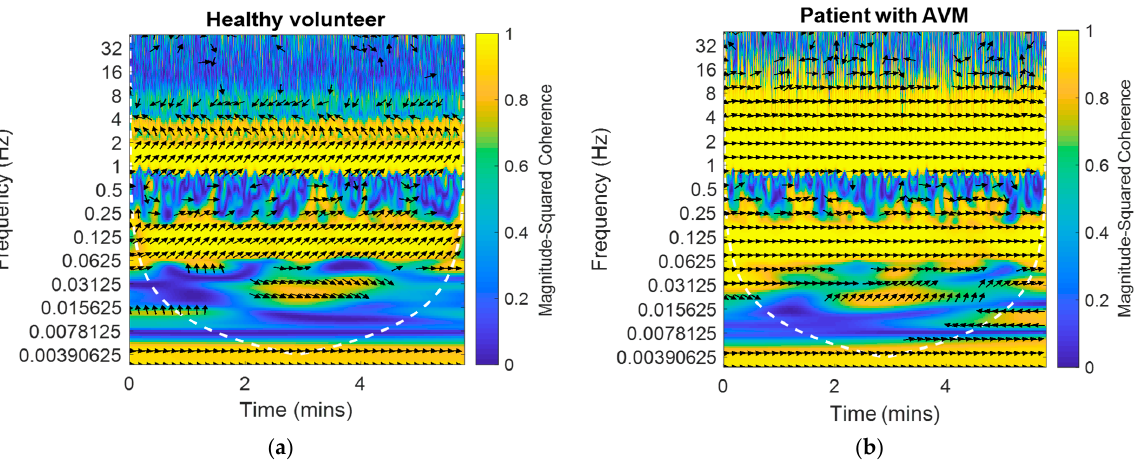
Figure 1. The example of the dependences of the phase shift between the BP and BFV signals in the left and right middle cerebral arteries against the background of the magnitude-squared coherence between the signals on time and pseudo-frequency: ( a ) For a healthy volunteer on one side; ( b ) For a patient with an arteriovenous malformation in the left middle cerebral artery on the AVM side.